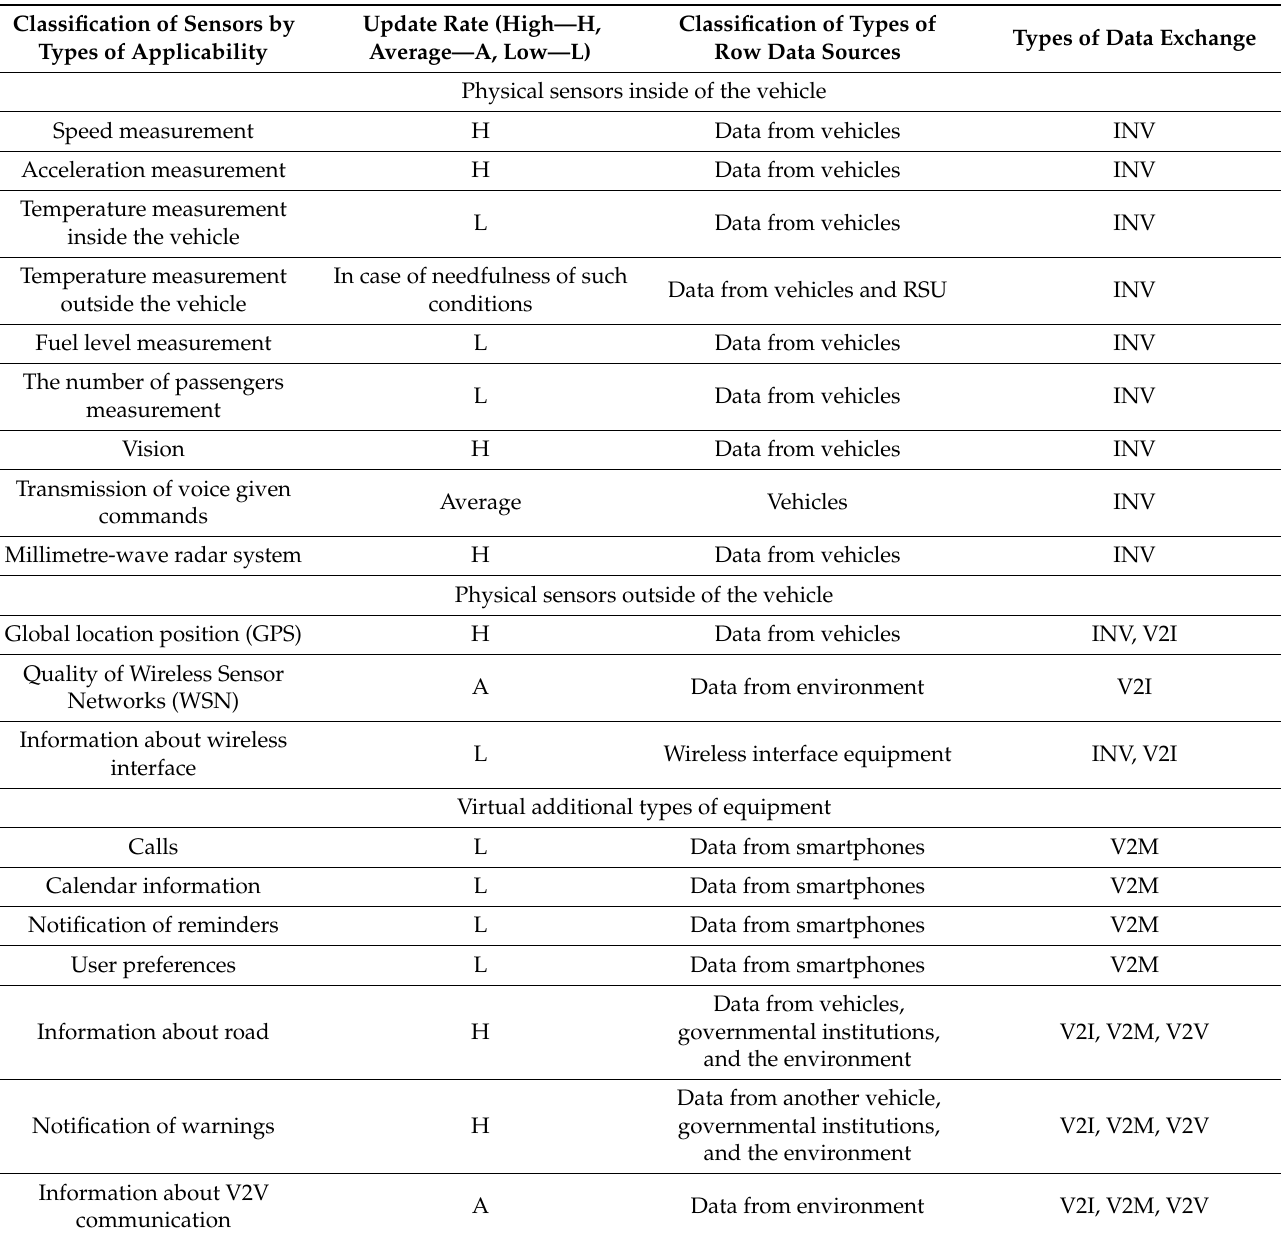
Table 5. Classification of sensors, by type, that were applied for the recognition of contextual data from WSNs in cargo